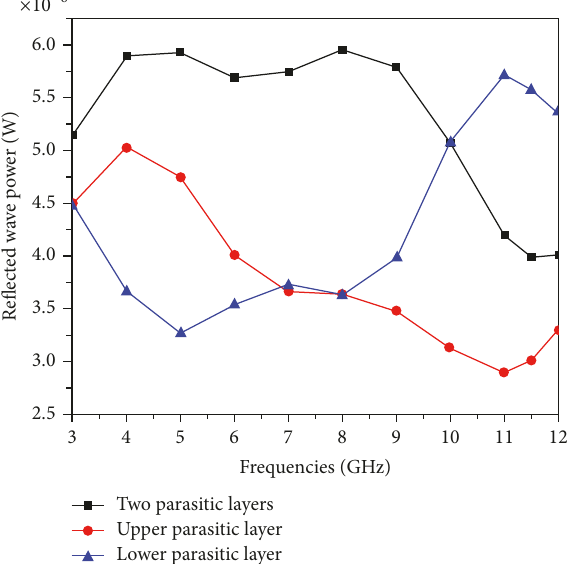
Figure 7: Total reflected wave power flow for parasitic layers alone and together.